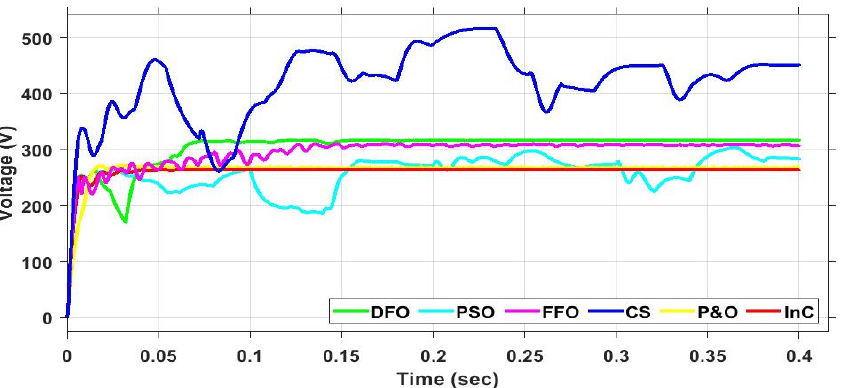
Figure 30. PS2 voltage comparison between all algorithms for MLPE Distributed PV